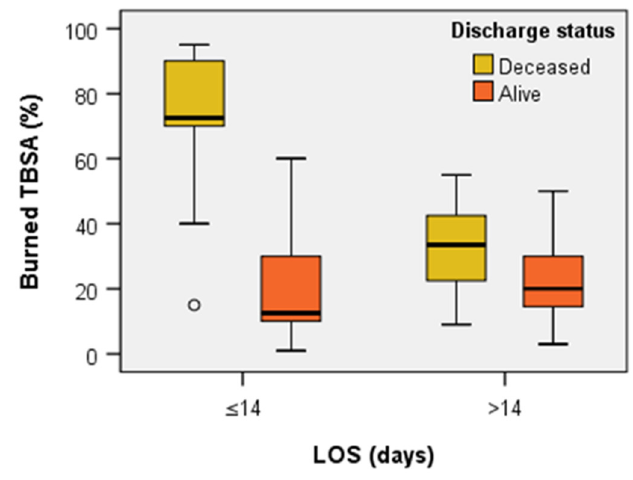
Figure 7. Comparison of TBSA (%) with LOS and patients’ discharge status. TBSA—total body surface area; LOS—length of stay.